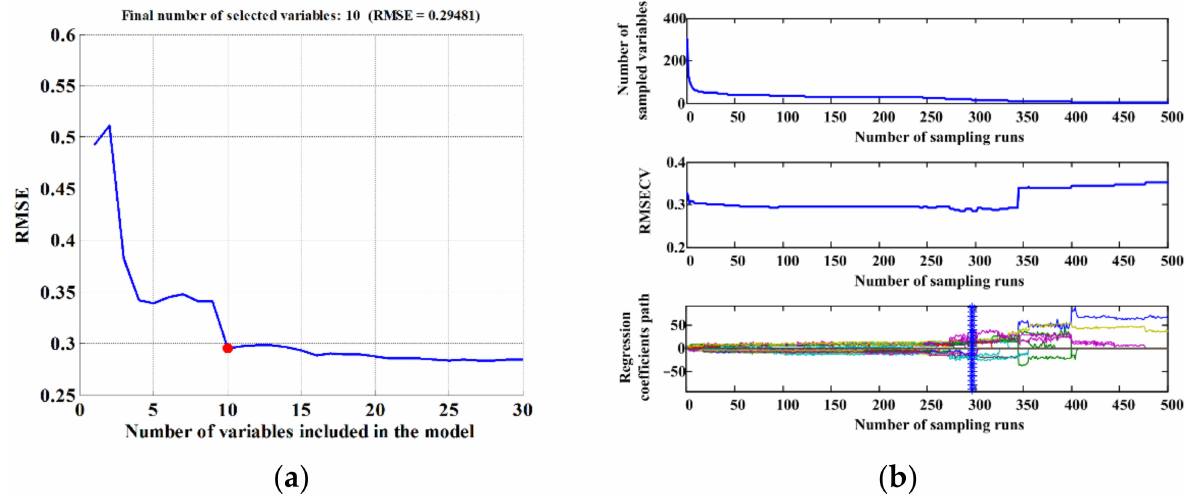
Figure 4. Wavelengths selection using SPA and CARS algorithms, ( a ) distribution maps of feature wavelengths selected by SPA; ( b ) parameter changes with sampling runs in wavelengths selection by CARS. RMSE: root mean squared error; RMSECV: root mean squared error in cross-validation; SPA: successful projects algorithm; CARS: competitive adaptive reweighted